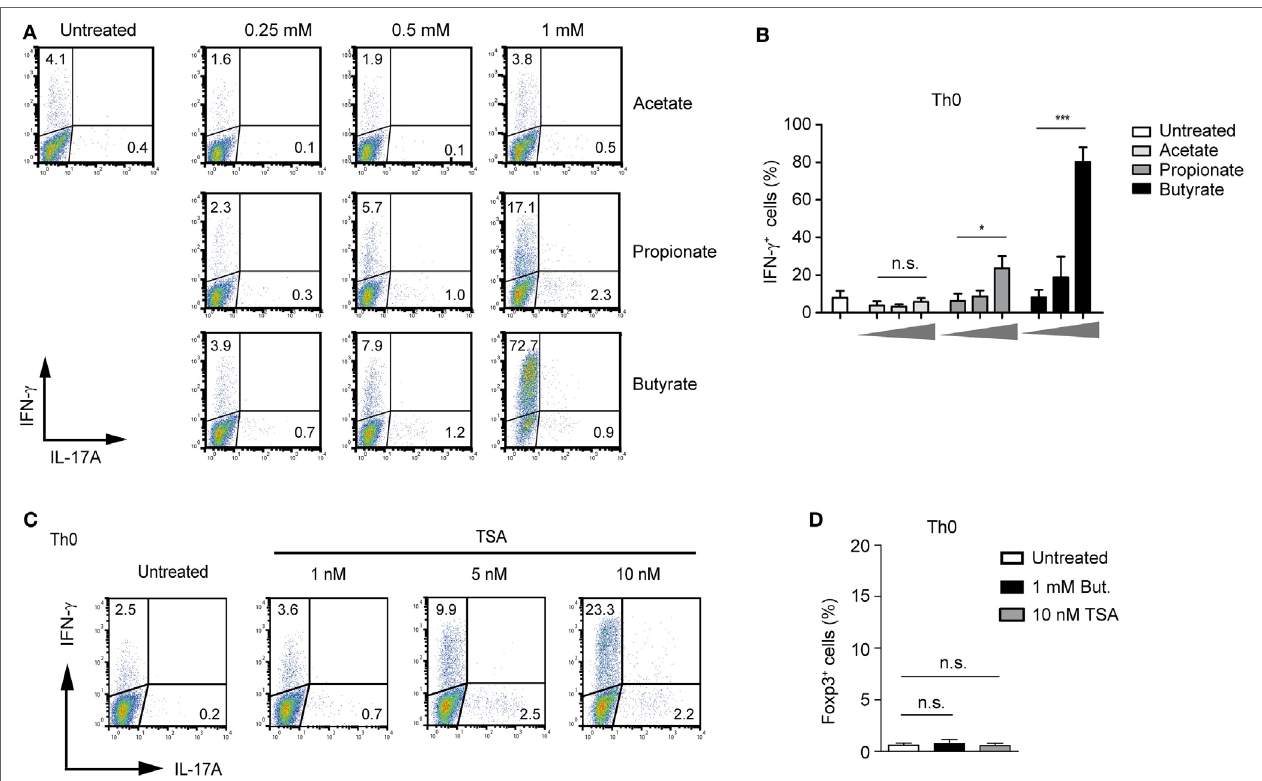
FigUre 4 | Butyrate induces IFN- γ expression in unpolarized CD4 + T cells. (a,B) FACS analysis of IFN- γ and IL-17A expression in CD4 + T cells cultured under unpolarized conditions in the presence of indicated short-chain fatty acid concentrations. Results in (B) represent the mean ± SEM; * P = 0.01–0.05, *** P < 0.001, n.s., not significant. Three independent experiments were performed. (c) CD4 + T cells were left unpolarized for 3 days in the presence of increasing TSA concentrations. Frequency of IFN- γ + and IL-17A + cells was determined using flow cytometry. Dot plots are representative of three similar experiments. (D) CD4 + T cells were left undifferentiated for 3 days in the presence of sodium butyrate and TSA, respectively. Intracellular staining for Foxp3 was performed by FACS analysis. Data are displayed as the mean ± SEM; n.s., not significant. Two experiments were